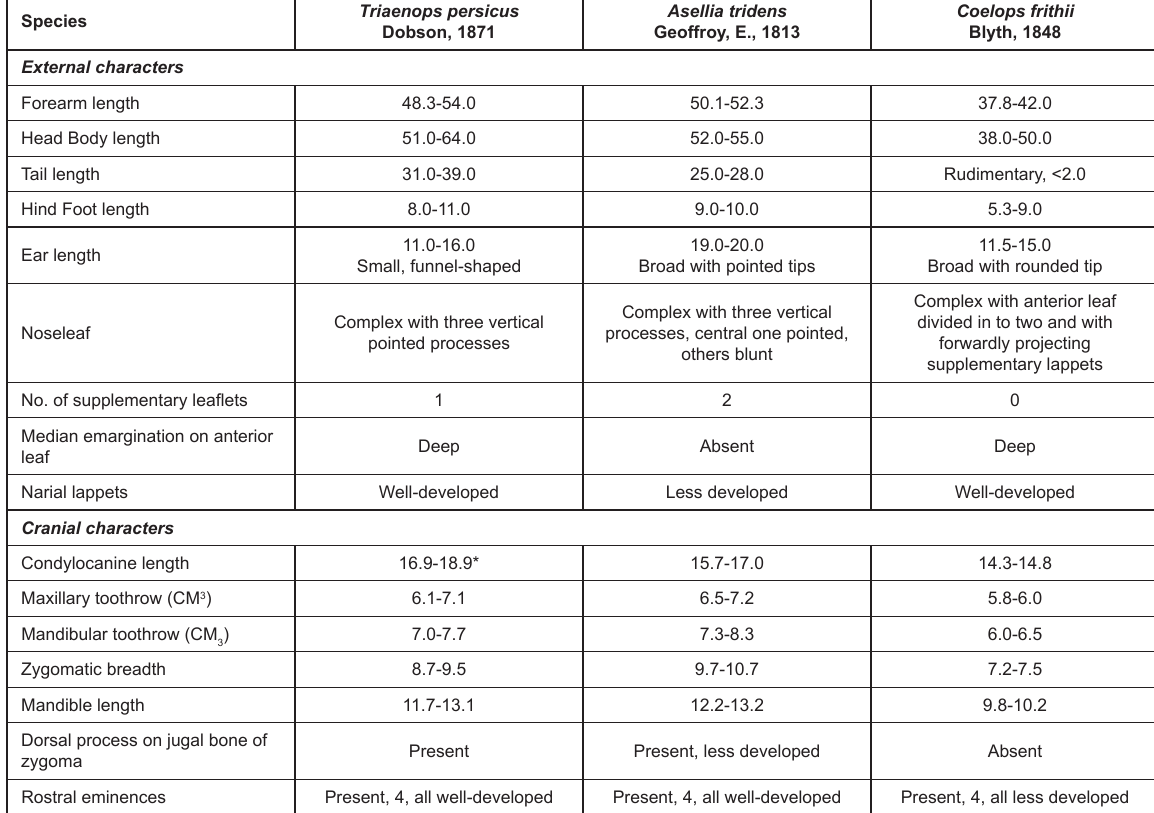
Table 5.2. Diagnostic morphological characters of one species each of the genera Triaenops Dobson, 1871; Asellia gray, 1838; and Coelops Blyth, 1848 present in South